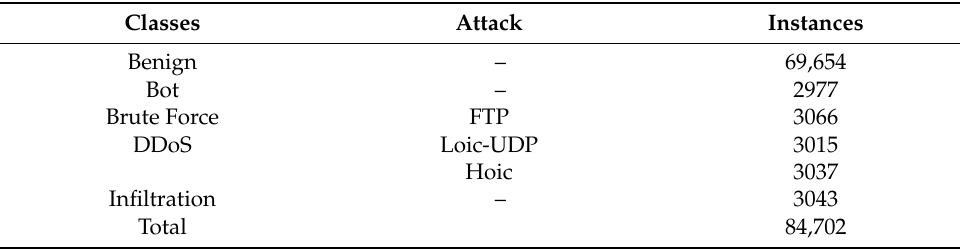
Table 3. Data Set Description, CICIDS2018.